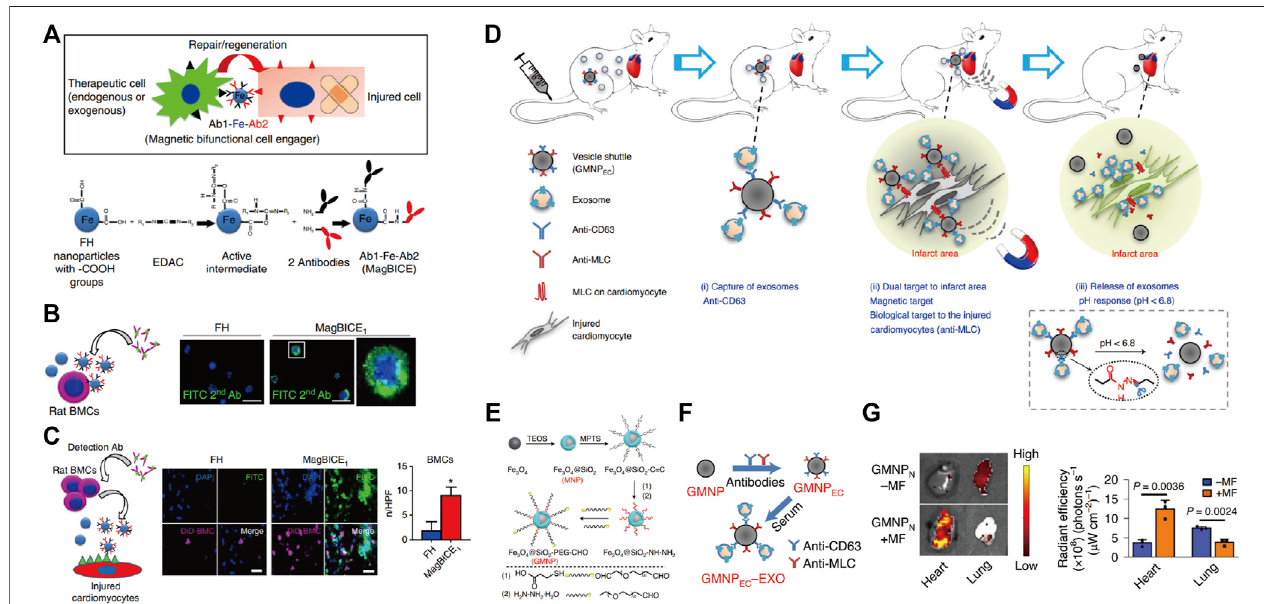
FIGURE2| Applyingantibody-conjugatedmagneticnanoparticlesforthetargetingdeliveryinthetreatment ofMI.Magneticantibody-linkednanomatchmakersfor therapeutic stem cell targeting in the treatment of MI. (A) Schematic representations ofthe cell matchmaking by magnetic bifunctional cell engager 1 (MagBICE) and the preparationofMagBICEnanoparticles. (B) FluorescentmicroscopicimagesshowingthebindingofMagBICE 1 ,butnotunconjugatedFeraheme(FH),toratbonemarrow mononuclear cells (BMCs). (C) Fluorescent microscopic images showing MagBICE 1 conjoined BMCs (DiD-labelled, magenta) with injured cardiomyocytes, Adapted with permission from Cheng et al., 2014. (D) Schematic representations of vesicle shuttle which can effectively collect, transport, and release circulating exosomes to infarcted areas of the hearts by the core-shell-corona structure by applying antibody-conjugated magnetic nanoparticles. (E) Schematic of the GMNP fabrication. (F) Schematicoftheconstructionofendothelialcelldenotedsurface-graftedmagneticnanoparticles(GMNP EC )bytheadditionofanti-CD63andanti-myosin light chain (MLC) antibodies to GMNPs, and the attachment of rat-derived exosomes from the in vitro serum to the anti-CD63 on the surface of GMNP EC nanoparticles (GMNP EC – EXO). (G) Exvivo fl uorescentimagingofintravenously( i.v. )injectedRhB-labelledGMNPNinMI-modelratswithorwithoutsubsequentexposuretoanexternal magnetic fi eld. Adapted with permission from Liu et al.,